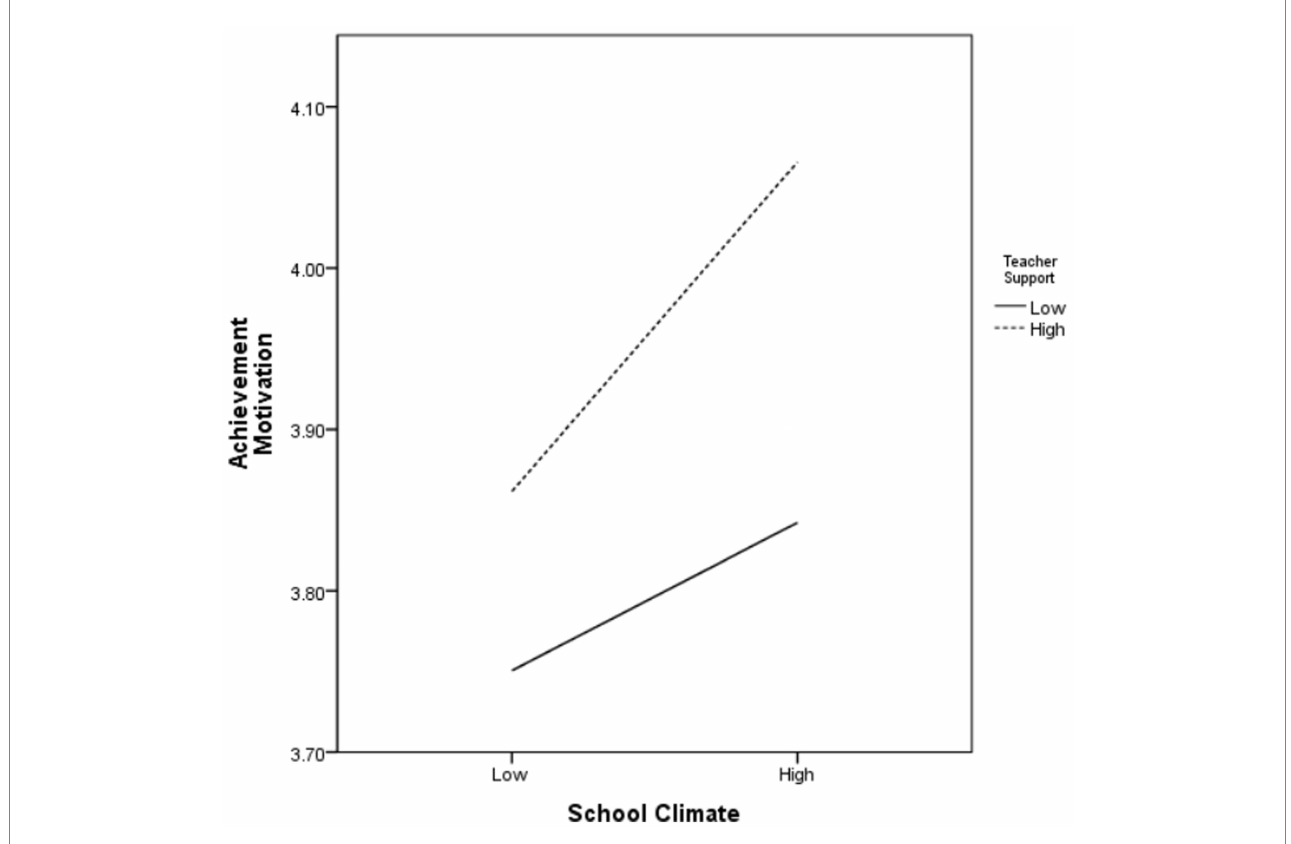
FIGURE 2 Moderating effects of teacher support on school climate and achievement